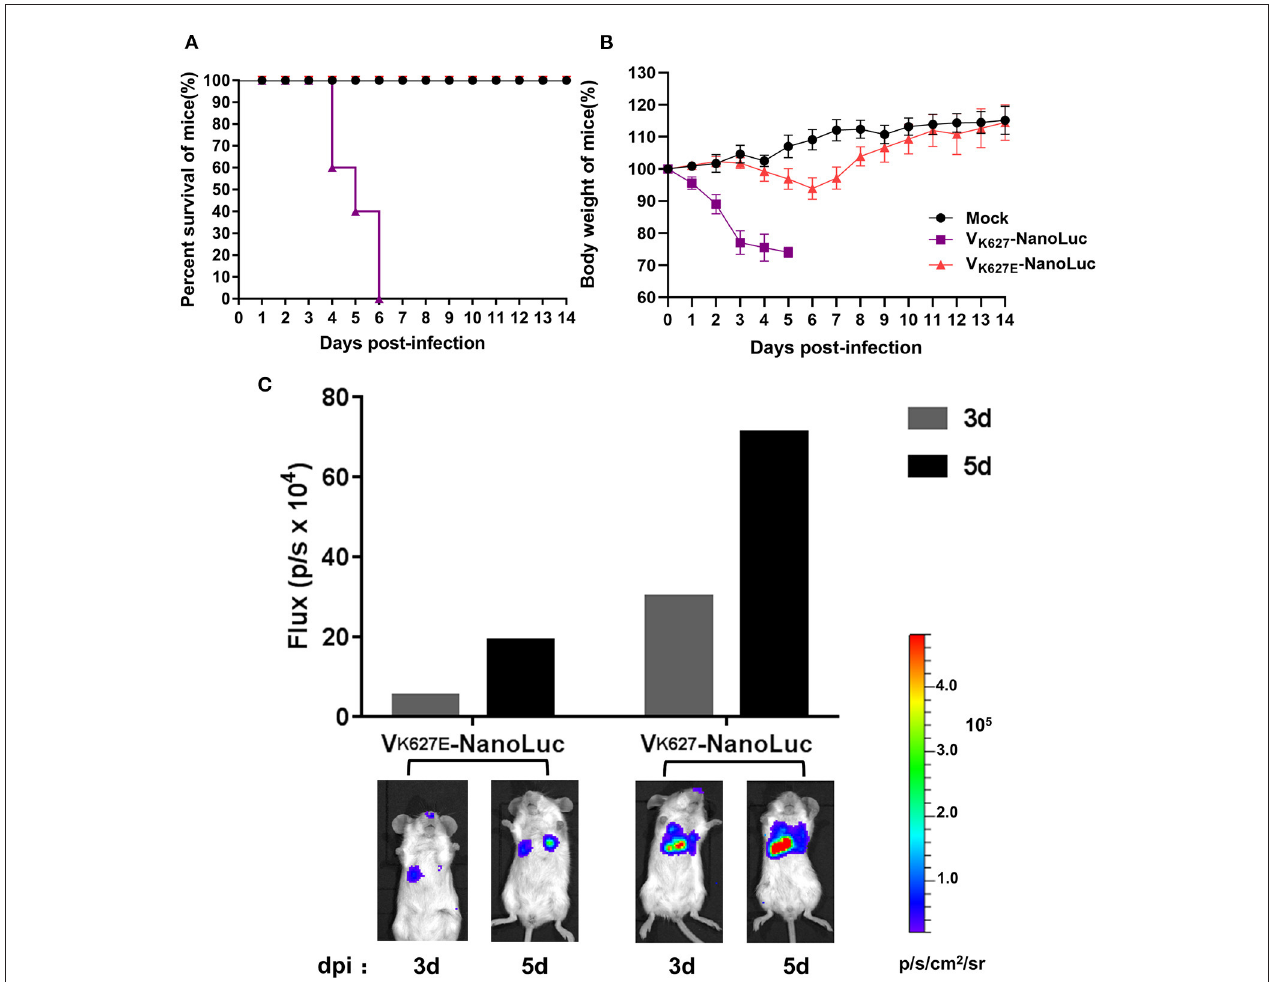
FIGURE 4 | V K627 -NanoLuc virus was attenuated in mice by a single K627E mutation in the PB2 protein. Mice ( n = 5) were infected with 10 6 EID 50 /50 µ l of V K627 -NanoLuc virus and V K627E -NanoLuc virus. Survival (A) and body weights (B) were monitored for 14 days. (C) Imaging of the same single mouse of each group was performed at 3 and 5